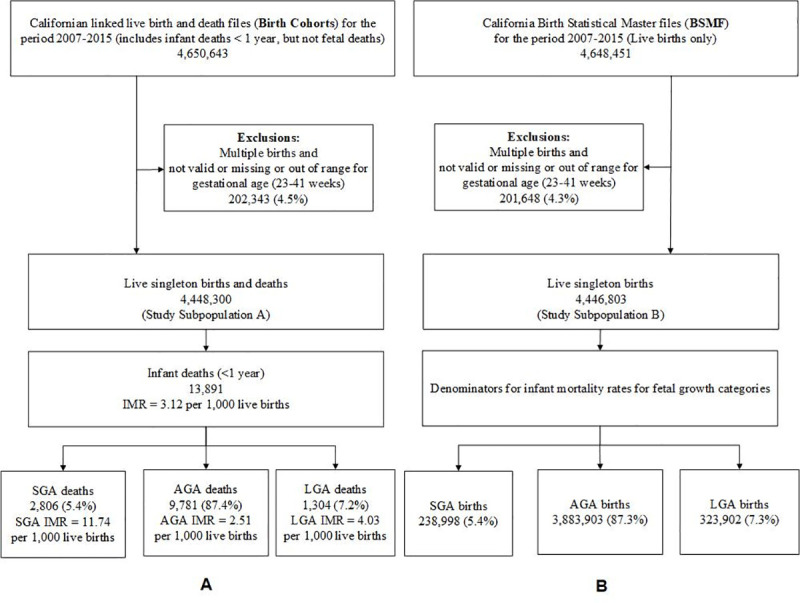
Screening criteria to identify study subpopulations (A) Californian linked birth and infant death files (Birth Cohorts), 2007–2015, and (B) Californian live births from the Birth Statistical Master files (BSBF), 2007–2015, to study infant mortality rate (IMR) by fetal growth (SGA (small-for-gestational-age), AGA (appropriate-for-gestational-age, and LGA (large-for-gestational-age) for singleton births only in California for the period 2007–2015.